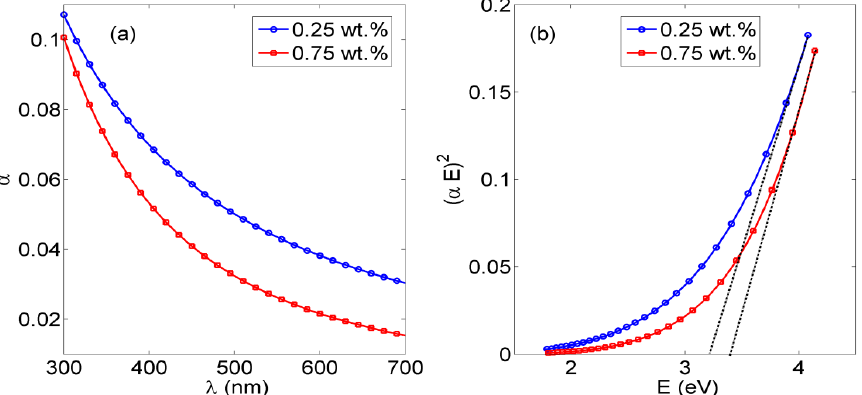
Figure 1. Poly(vinyl alcohol) (PVA) nanofibers (NFs) with in situ embedded cerium oxide nanoparticles (ceria NPs):( a ) Absorbance curve;( b ) Bandgap curve.